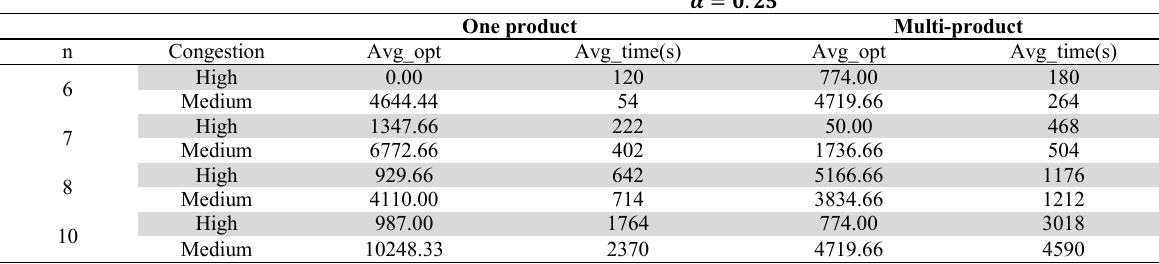
The results of the rolling horizon algorithm under high dissipation strategy (cid:2235) (cid:3404) (cid:2777).(cid:2779)(cid:2782) One product Multi-product